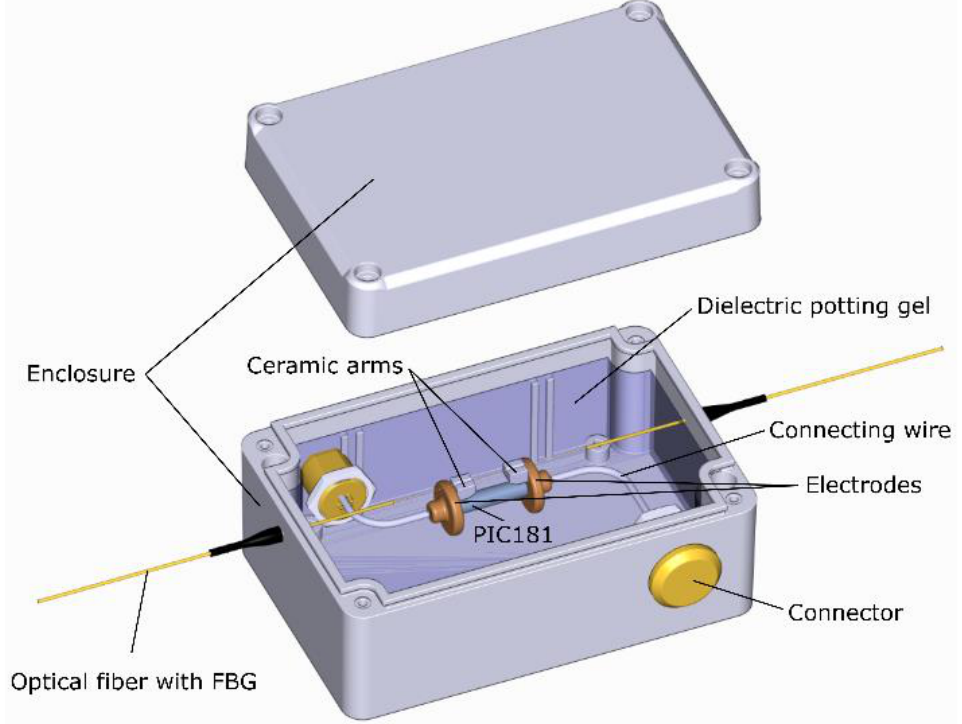
Figure 1. A medium voltage transducer packaged into an ABS enclosure and potted with a dielectric